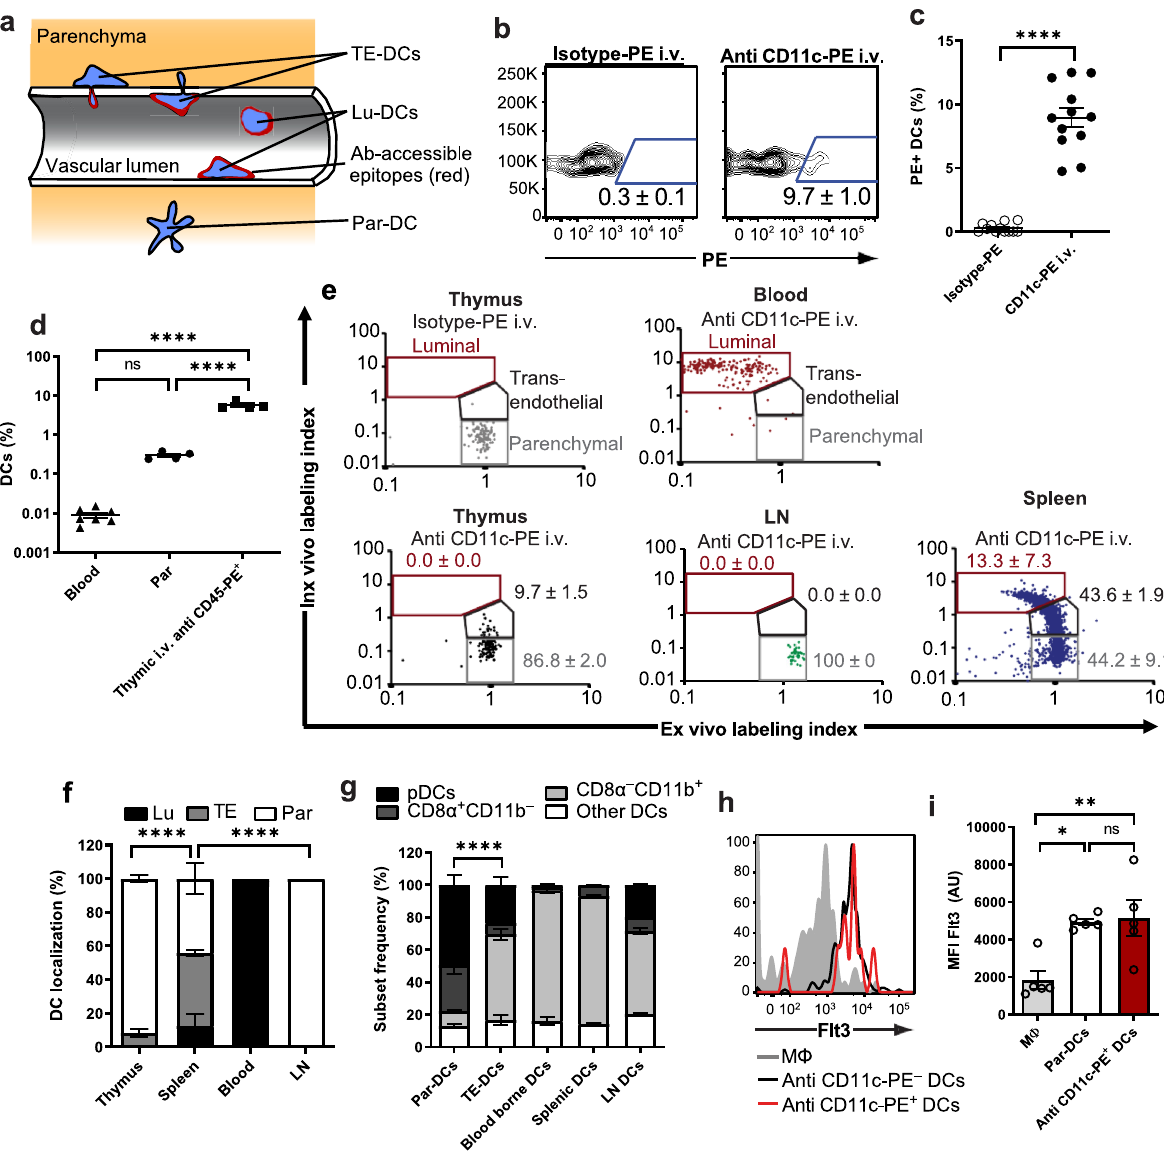
Fig. 4 Characterization of thymic TE-DCs. a Schematic illustration of the distribution of thymic DCs in the parenchyma (Par-DC), vessel lumen (Lu-DC), and transendothelial localization (TE-DC) and the expected accessibility of epitopes (red) for IV injected mAbs. b and c C57BL/6 mice were injected IV with anti-CD11c-PE or isotype-PE mAb and euthanized 2minutes later. b Representative FACS plots showing PE + DCs in ET single-cell suspensions after gating on total CD11c + DCs. c Frequency of thymic PE + DCs from two independent experiments; n = 12 mice/group; n = 5; ****: P < 0.0001 (Student ’ s two-tailed, unpaired t test). d Mice were injected with anti-CD45-PE mAb and euthanized after 2 mins. The frequency of DCs was determined among total blood and thymic leukocytes and among CD45-PE + thymic leukocytes. n = 5 mice (one-way ANOVA, n.s.: not signi fi cant, **** P <0.0001). e Representative plots of in vivo and ex vivo labeling indices of DCs from blood, thymus, lymph nodes (LN), and spleen that were determined as described in Results and Supplementary Fig. 3. Gates re fl ecting parenchymal and luminal localization were set based on labeling indices obtained from thymic DCs after injection of isotype-PE and analysis of anti-CD11c-PE stained blood-borne DCs, respectively. For a transendothelial localization, in which only a fraction of CD11c epitopes should be accessible from the blood, a third gate was de fi ned in which cells display greater ex vivo and in vivo labeling indices than luminal and parenchymal DCs, respectively. f Percentage of Lu-DC, Par-DC, and TE-DCs in thymus, spleen, blood, and LN. n = 4 mice/group (two-way ANOVA, **** P <0.0001). g DC subset composition of thymic Par-DC and TE-DCs as well as blood-borne, splenic, and LN DCs. n = 5 mice/group (two-way ANOVA, **** P < 0.0001). h and i Thymic macrophages (M ϕ ), Par-DCs, and PE + DCs were evaluated for Flt3 expression. h Representative FACS histogram; i mean fl uorescence intensities (MFI) of each cell population. n = 3 independent experiments with fi ve mice/each (one-way ANOVA, ** P = 0.0078, * P = 0.0115). Bars and error bars represent mean ±SEM. See also Supplementary Figs. 2 –